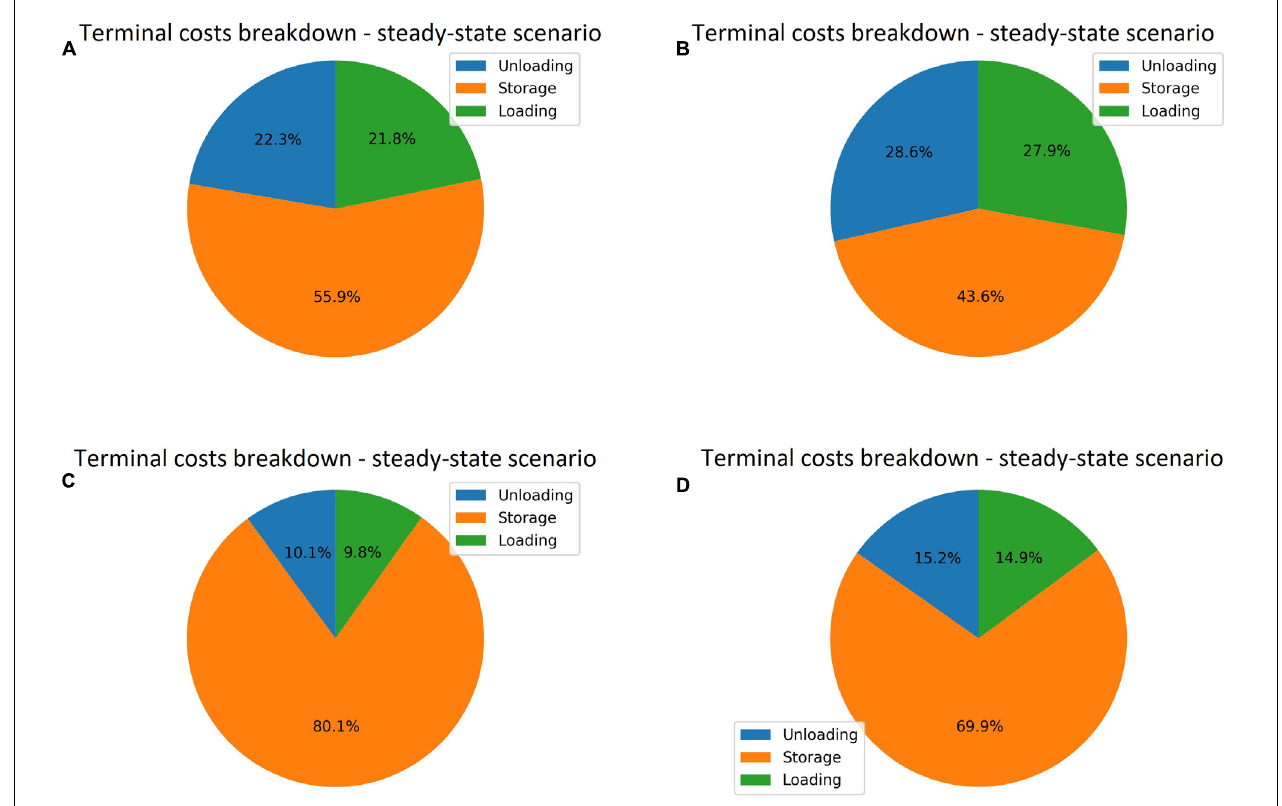
FIGURE 5 | Terminal costs breakdown, steady-state scenario, cases ( A–D